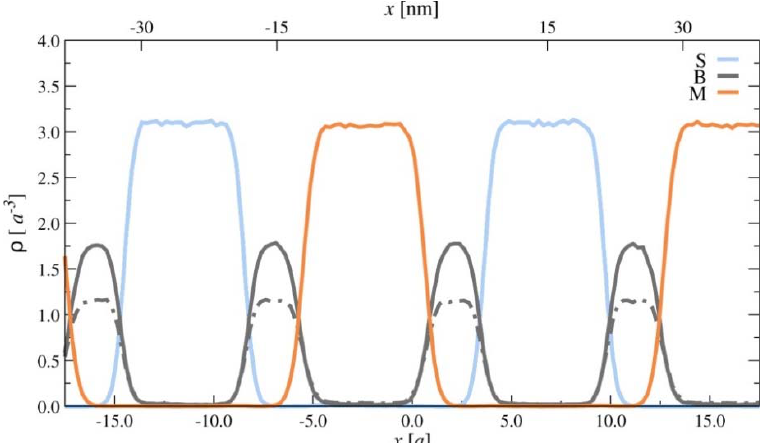
Figure 4. Monomer density distribution of SBM terpolymer (solid lines) with φ = 75% hPB (dashed line) in the lamellar phase. The x -axis lies perpendicular, relative to the lamellae.